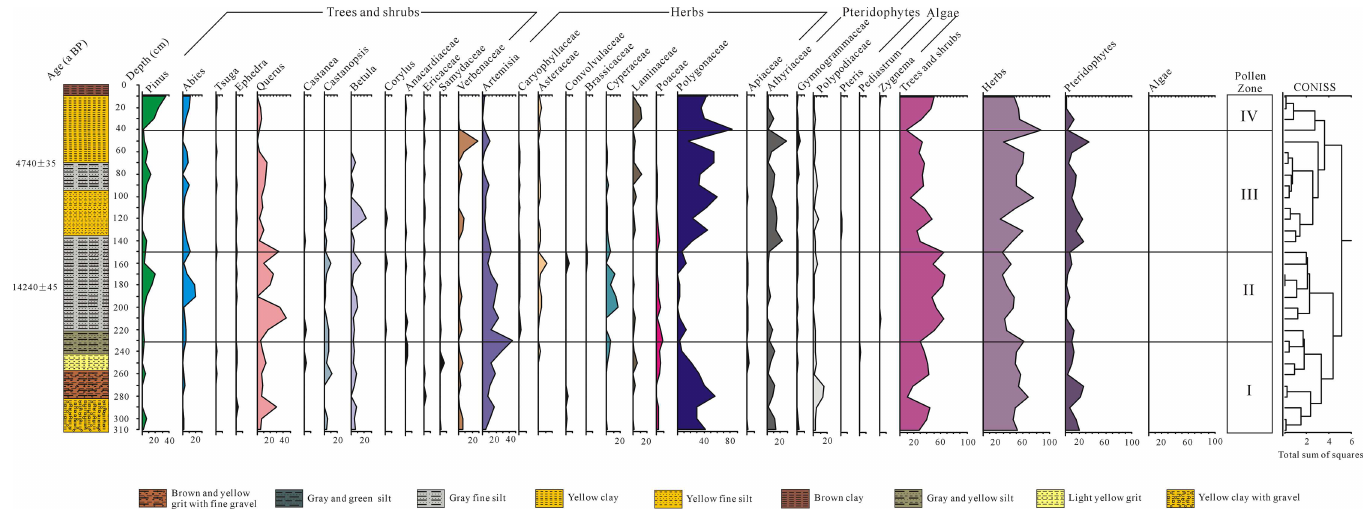
Fig 5. Pollen percentage diagram for major palynomorphs from Shudu Lake core,